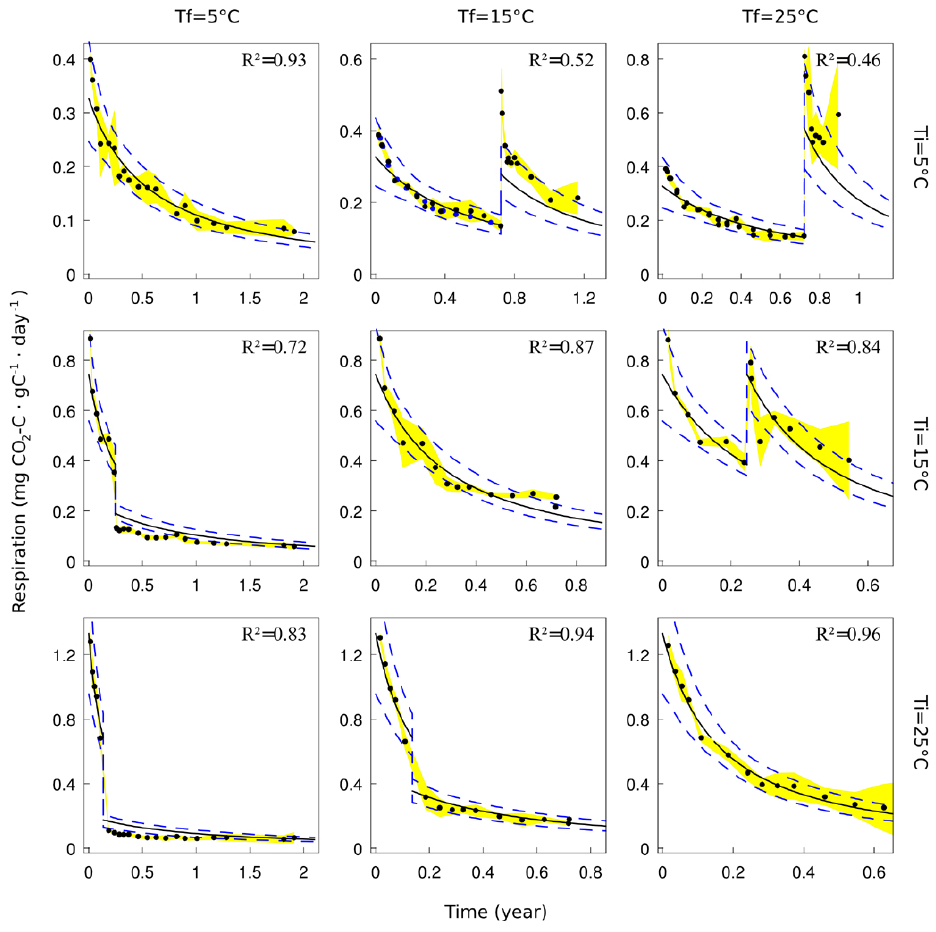
Fig. 2. Model predictions of respiration rates for the one initial quality, flexible decomposer efficiency model and observed respiration rates for all combinations of initial ( T i ) and final ( T f ) temperatures (5 ◦ C, 15 ◦ C, and 25 ◦ C.) Weighted ensemble run predictions (solid black line) with max/min curves (blue dashed lines) for the behavioural parameter sets. The yellow fields show 95% error bounds around measured data points (dots). Least square R 2 -values are shown in top right corner of each